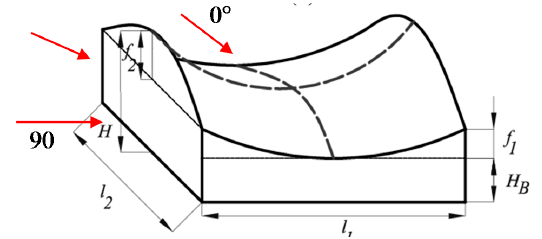
Figure 1. Geometrical